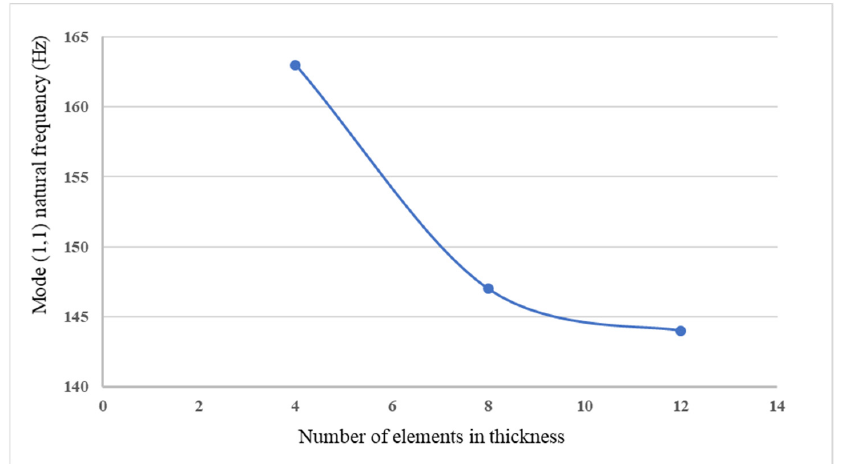
Figure 2. Finite element mesh.